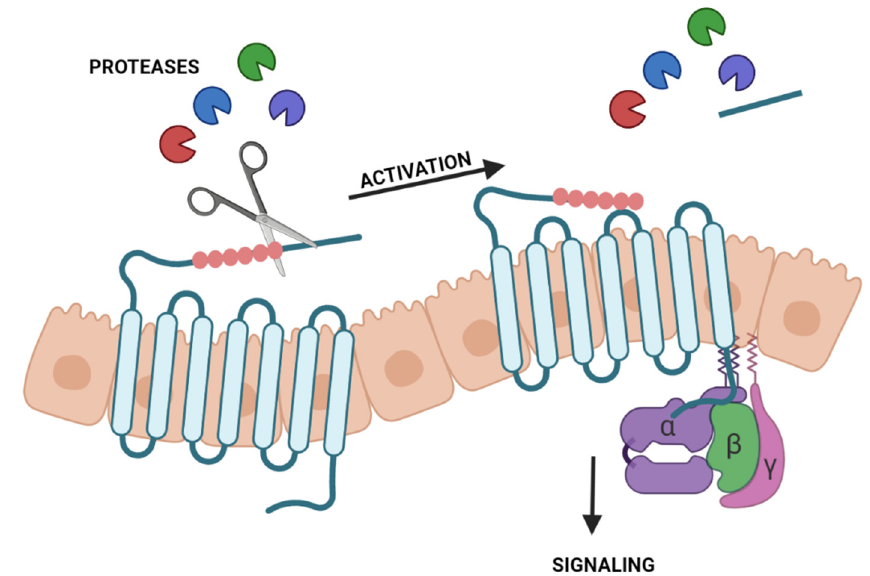
Figure 2. Activation of protease-activated receptors (PARs) by proteases. Proteases cleave the N- terminal exodomain of a specific PAR. The new N-terminal acting as a tethered ligand interacts with the extracellular loop-2 starting intracellular